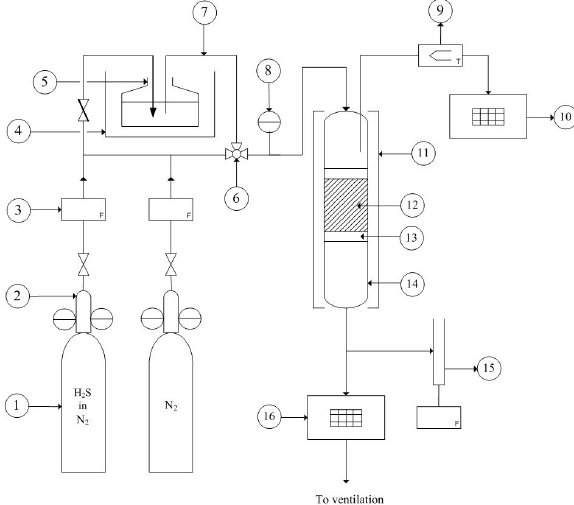
Fig. 2. Schematic diagram of the experimental setup for H 2 S sorption study: (1) gas cylinder, (2) pressure regula- tor, (3) mass flow controller, (4) water bath, (5) humidifier, (6) three-way valve, (7) insulated pipeline, (8) pressure gauge, (9) thermocouple, (10) temperature indicator, (11) heating jacket, (12) adsorbent, (13) glass wool, (14) stain- less column, (15) bubble soap flow meter, (16) H 2 S gas analyzer.